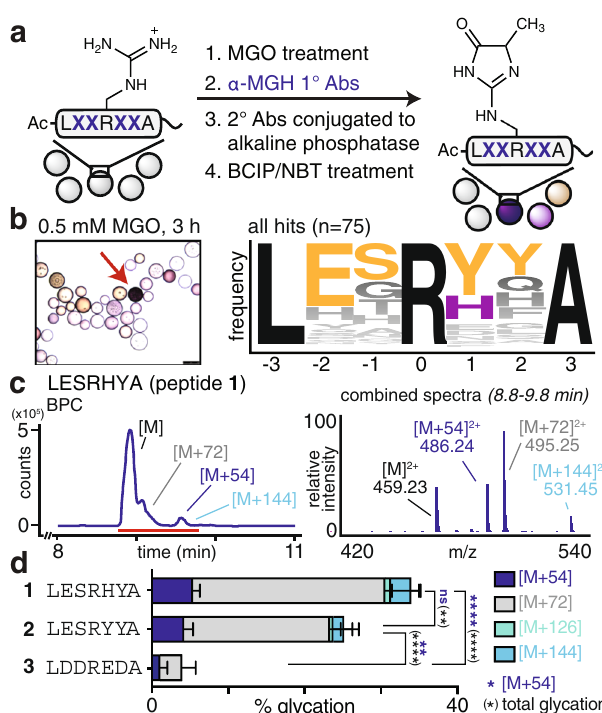
Fig. 2 A combinatorial approach to identify peptides that favor a single MGH isomer. a To identify sequences that promote MGH-1 formation, a library of peptides with randomized residues surrounding a central arginine were treated with 0.5 mM MGO for 3 h at 37 °C in 20 mM phosphate buffered saline (PBS) at pH 7.3. MGH-1-modi fi ed sequences were selected by incubation with α -MGH-1 primary antibodies, which was followed by treatment with secondary antibodies conjugated to alkaline phosphatase, and lastly, colorimetric detection with BCIP/NBT reagents. b Dark purple “ hit ” beads (red arrow) were selected, cleaved and identi fi ed using LC-MS/ MS with de novo sequencing. 75 total hit beads were selected, sequenced, and found to converge on a consensus motif (LESRYYA, n = 2), which is nearly identical to the most frequently selected hit sequence (LESRHYA, n = 6). c Puri fi ed synthetic peptides that were N-terminally acetylated were allowed to react with equimolar MGO (1 mM) in pH 7.3 PBS for 3 h at 37 °C, and were then analyzed by LC-MS. Representative base peak chromatograms (BPC, left) and combined mass spectrum (right) for the reaction of the top hit, Ac-LESRHYA, (peptide 1 ) with MGO. d Distribution of glycation products observed for the in vitro glycation of the most frequently selected hit sequence (Ac-LESRHYA, peptide 1 ), the consensus motif (Ac-LESRYYA, peptide 2 ) and a negative hit sequence, (Ac- LDDREDA, peptide 3 ). Stacked bar graphs are plotted as mean ± standard deviation for each mass adduct. Individual data points are shown in Supplementary Fig. 8. Data are derived from independent experiments: peptide 1 , n = 8; peptide 2 , n = 5; peptide 3 , n = 3. Legend: blue, [M + 54]; gray, [M + 72]; green, [M + 126]; cyan, [M + 144]. A nondirectional (two- tailed) one-way ANOVA using Tukey ’ s multiple comparison was used to determine if each peptide yielded statistically signi fi cant differences in [M + 54] (blue) or total glycation (black) levels. p < 0.05(*), p < 0.01(**), p < 0.001(***), p < 0.0001(****). Source data are provided as a Source Data fi le. Additional statistical information, including exact p -values, is available in an additional Supplementary Data fi